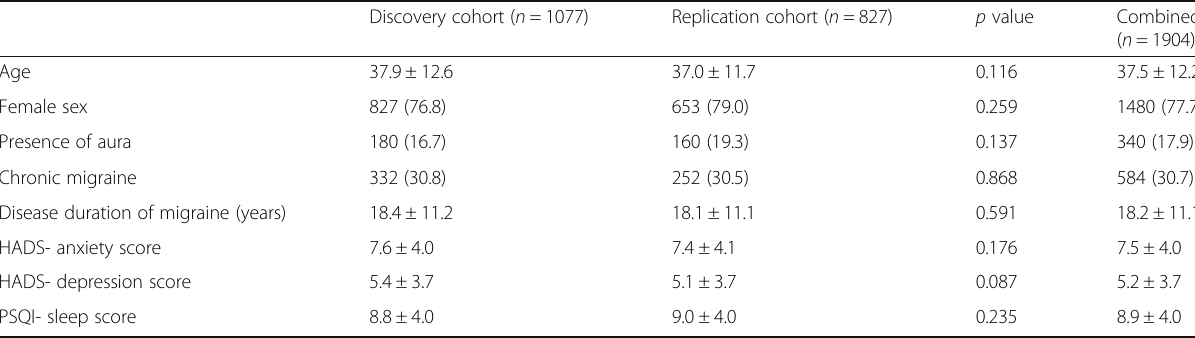
Table 1 Baseline demographics and clinical data of participants